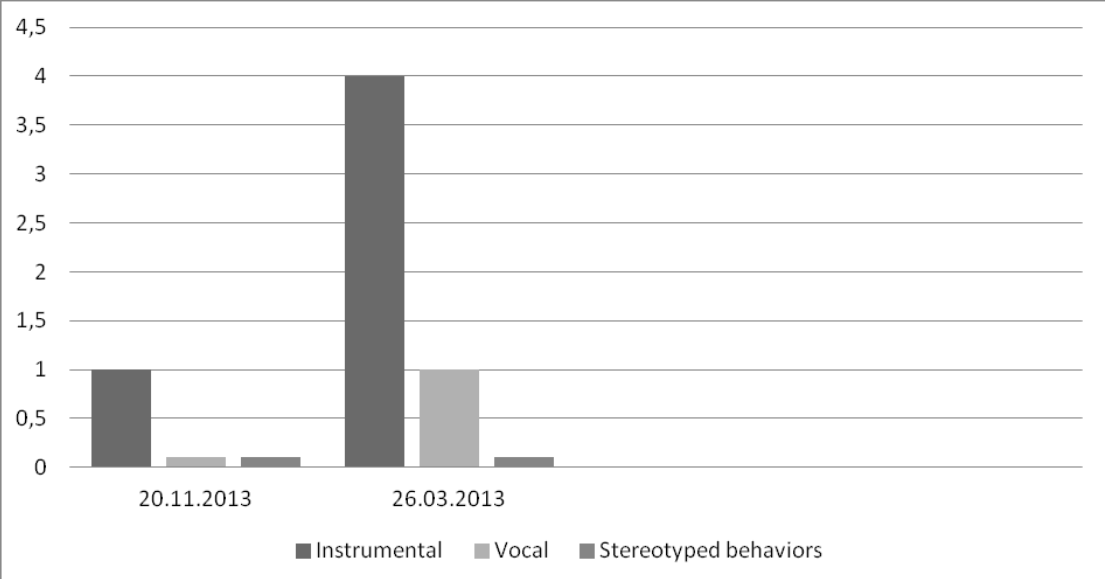
Source: Chart based on Scale II Musical Communicativeness Rating Form (Nordoff, Robbins, 2007, p.